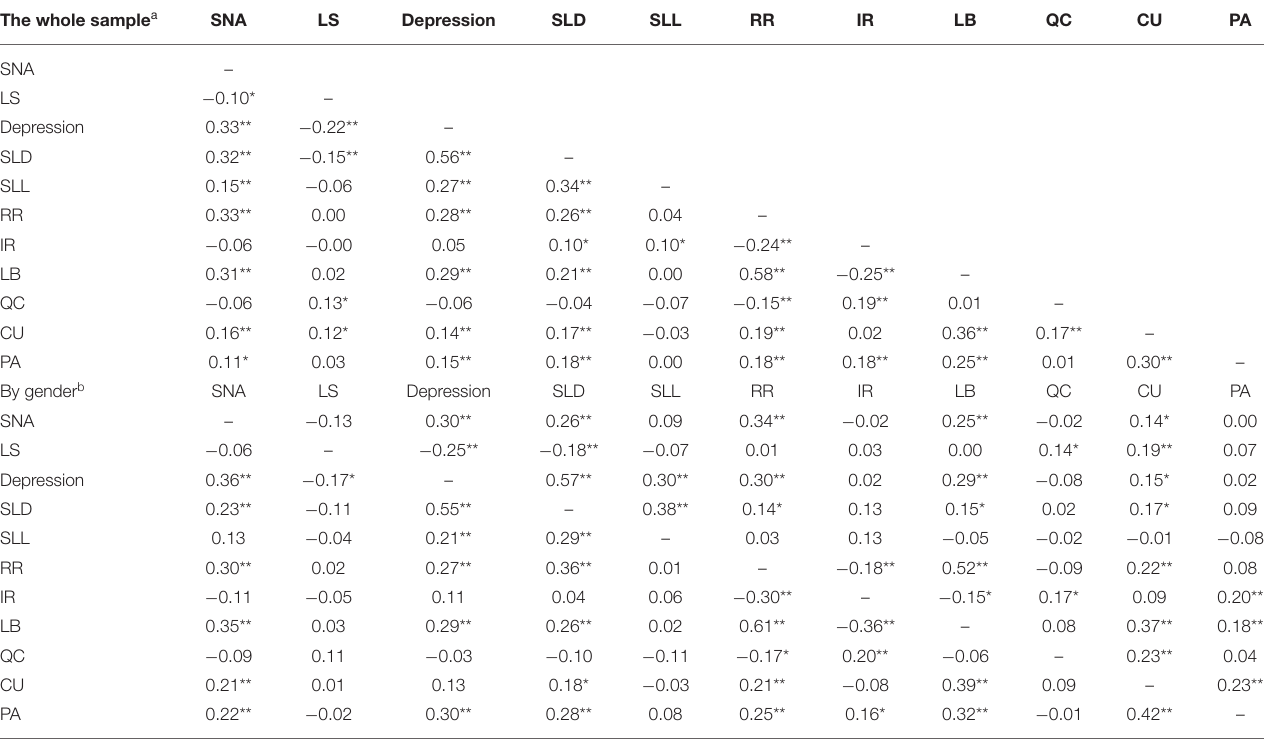
TABLE 2 | Correlations between social networking addiction, health indicators, and internet-specific parenting behaviors. The whole sample a SNA LS Depression